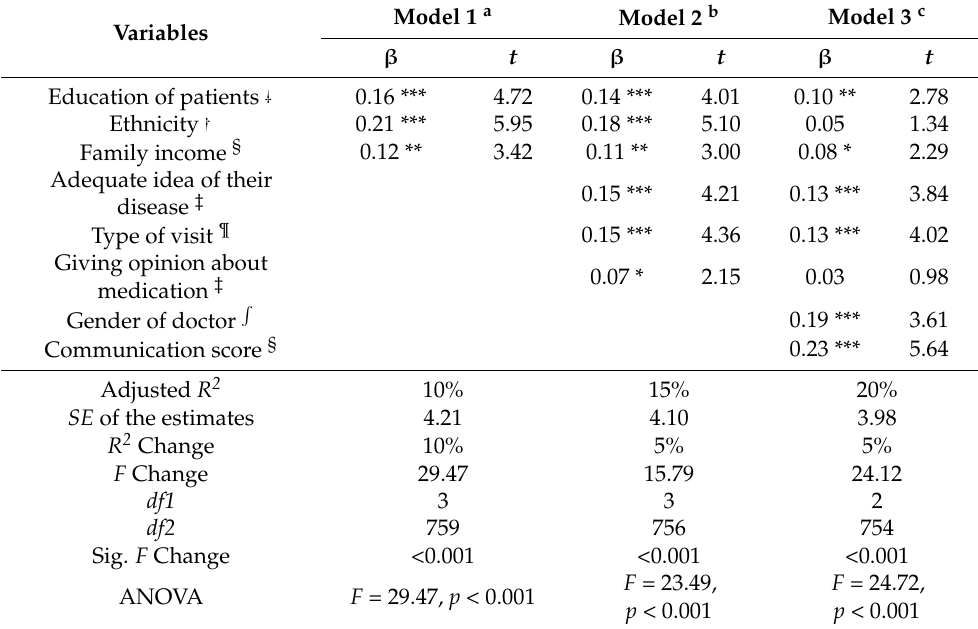
Table 3. Multiple linear regression analysis showing factors associated with longer appointment length in the medical consultation with the model summary d .